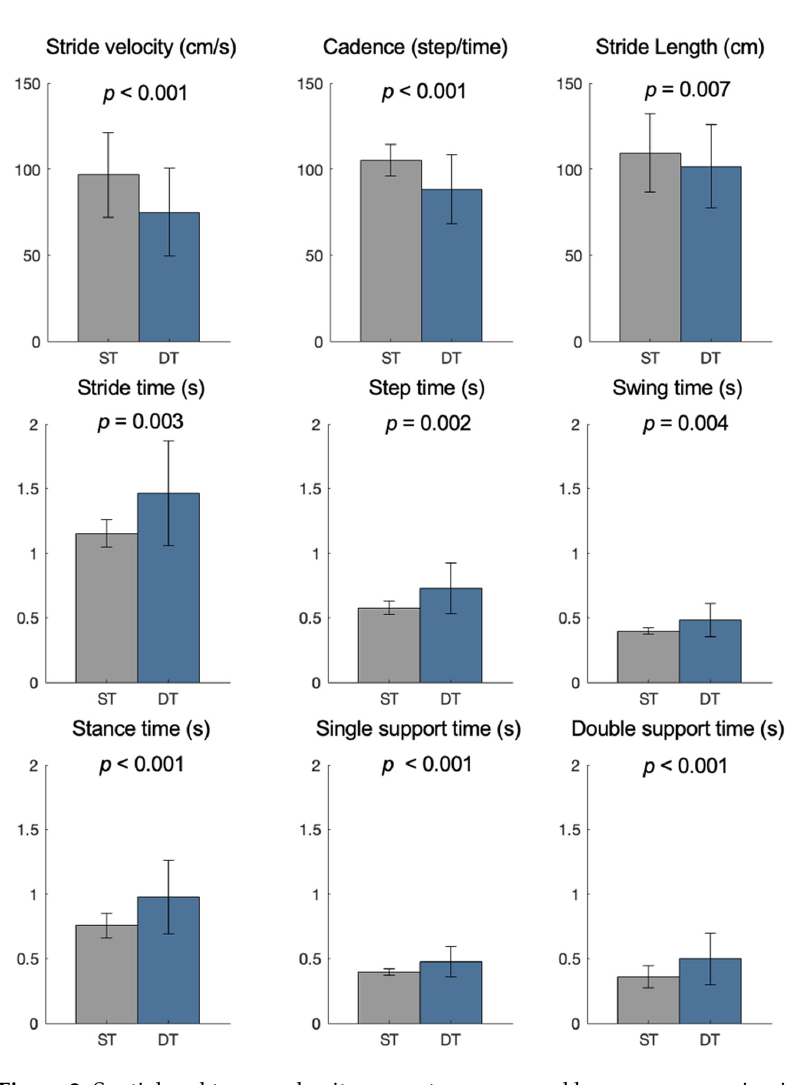
Table 2. Test–retest reliability of spatio-temporal parameters computed by pressure-sensing in- soles during single and dual-tasking conditions. Condition